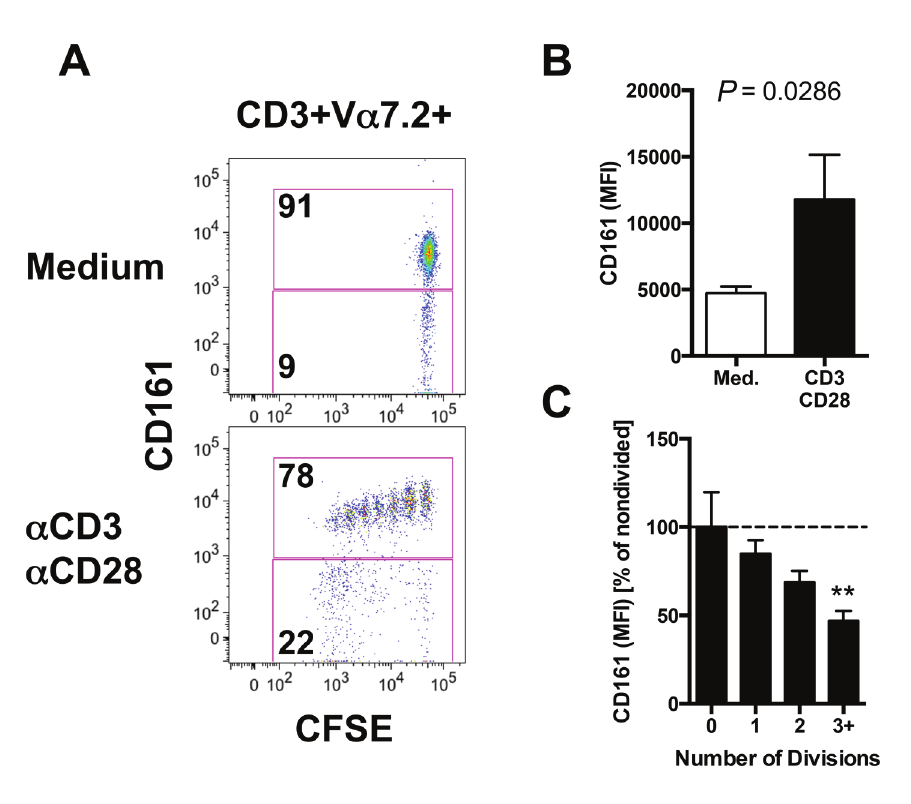
Figure 3. Cell Division and Reduction in Surface CD161 Expression Following TCR-Mediated Stimu- lation. (A) Representative plots show CD161 expression and CFSE dilution (proliferation) in CD3 + Vα7.2 + cells following 4 days culture with control medium (Med.) or stimulating antibodies to CD3 (αCD3) and CD28 (αCD28). (B) The mean fluorescence intensity (MFI) of CD161 staining on undivided CD161 + cells as shown in (A) (n = 4; Mann-Whitney test). (C) The MFI of CD161 staining on CD161 + cells at each round of division normalized to non-divided cells (n = 4; Kruskal-Wallis test). **P ≤